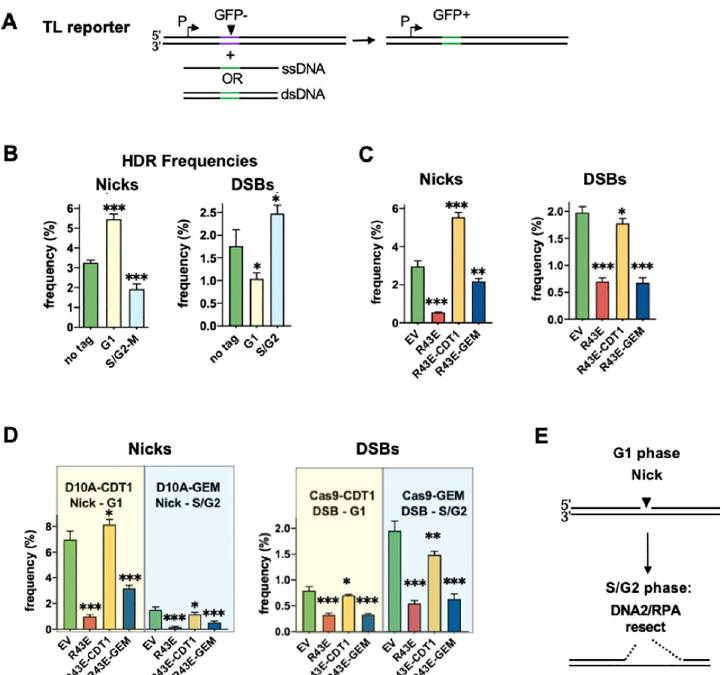
Fig 3. Cell cycle regulates HDR at nicks. (A) Traffic Light (TL) reporter [13] assay for HDR. The reporter carries a GFP gene rendered defective by a 38 bp insertion (purple), and driven by an upstream SFFV promoter (P). Repair is initiated by nicks or DSBs targeted to the insertion (arrowhead), and supported by either single-stranded DNA complementary to either strand or by a duplex DNA donor. HDR that replaces the 38 bp insertion with a 17 bp correction cassette (green) will correct the defective GFP gene, resulting in GFP + cells. (B) Effect on HDR frequencies of restriction of nicks or DSBs to G1 or S/G2 phase. HDR frequencies were determined using the TL reporter in 293T TL cells transfected with untagged Cas9D10A or Cas9, or with derivatives bearing CDT1 or GEM tags to restrict cleavage to G1 or S/G2 phase, respectively. Cleavage was targeted by gRNA9 and supported by a cN ssDNA donor for a-HDR (nicks) or a plasmid donor for c-HDR (DSBs). Frequency values represent the mean ± SEM from a representative experiment; � , �� , and ��� indicate p < 0.05, p < 0.01, and p < 0.001, respectively, for the frequency difference between indicated sample and sample transfected with untagged construct. (C) Effect on HDR frequencies at nicks and DSBs of restriction of the inhibitory activity of RPA1-R43E to G1 or S/G2 phase. Frequency values represent the mean ± SEM from a representative experiment; � , �� , and ��� indicate p < 0.05, p < 0.01, and p < 0.001, respectively, for the frequency difference between indicated sample and sample transfected with empty vector (EV). (D) Effect on HDR frequencies at nicks and DSBs of cell cycle restriction of both cleavage and RPA1-R43E activities. Results obtained when cleavage was restricted to G1 or S/G2 distinguished by yellow or blue shading. Other details as in panel B. (E) Diagram of how a nick generated in G1 phase may persist to undergo resection later in cell cycle. Resection occurs within a zone extending 3’ and 5’ of the nick, consistent with participation of DNA2/RPA. While the analysis reported here does not directly connect the importance of RPA activity in S/G2 phase to its well-studied role in DNA2/RPA-mediated resection, it is consistent with that function.